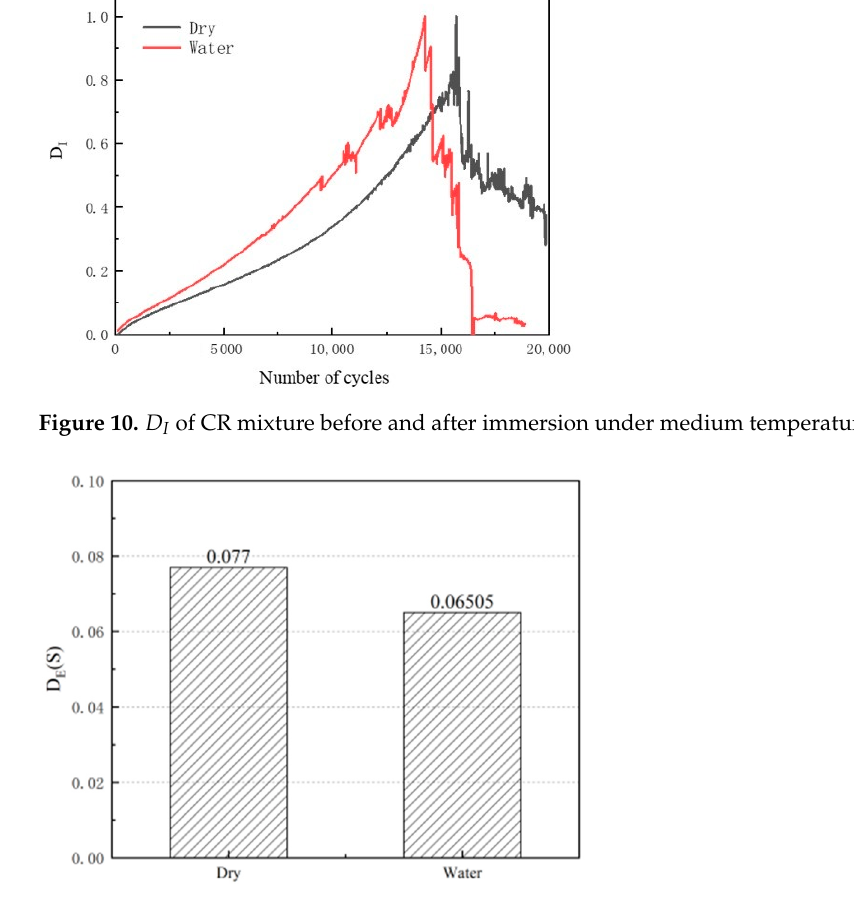
Figure 11. D E of CR mixture before and after immersion under low temperature fracture.